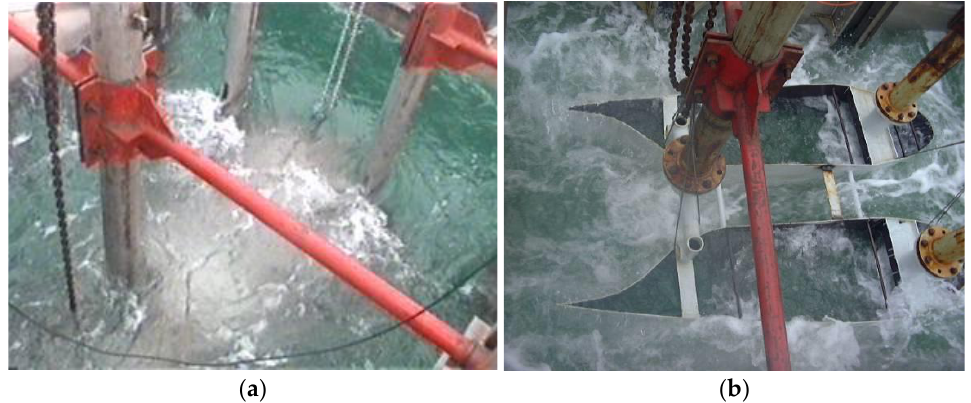
Figure 9. Duct scale model D3 dragged immersed by the raft in motion ( a ); the scaled planar profile of duct model D3 dragged immersed by the raft in motion ( b ).